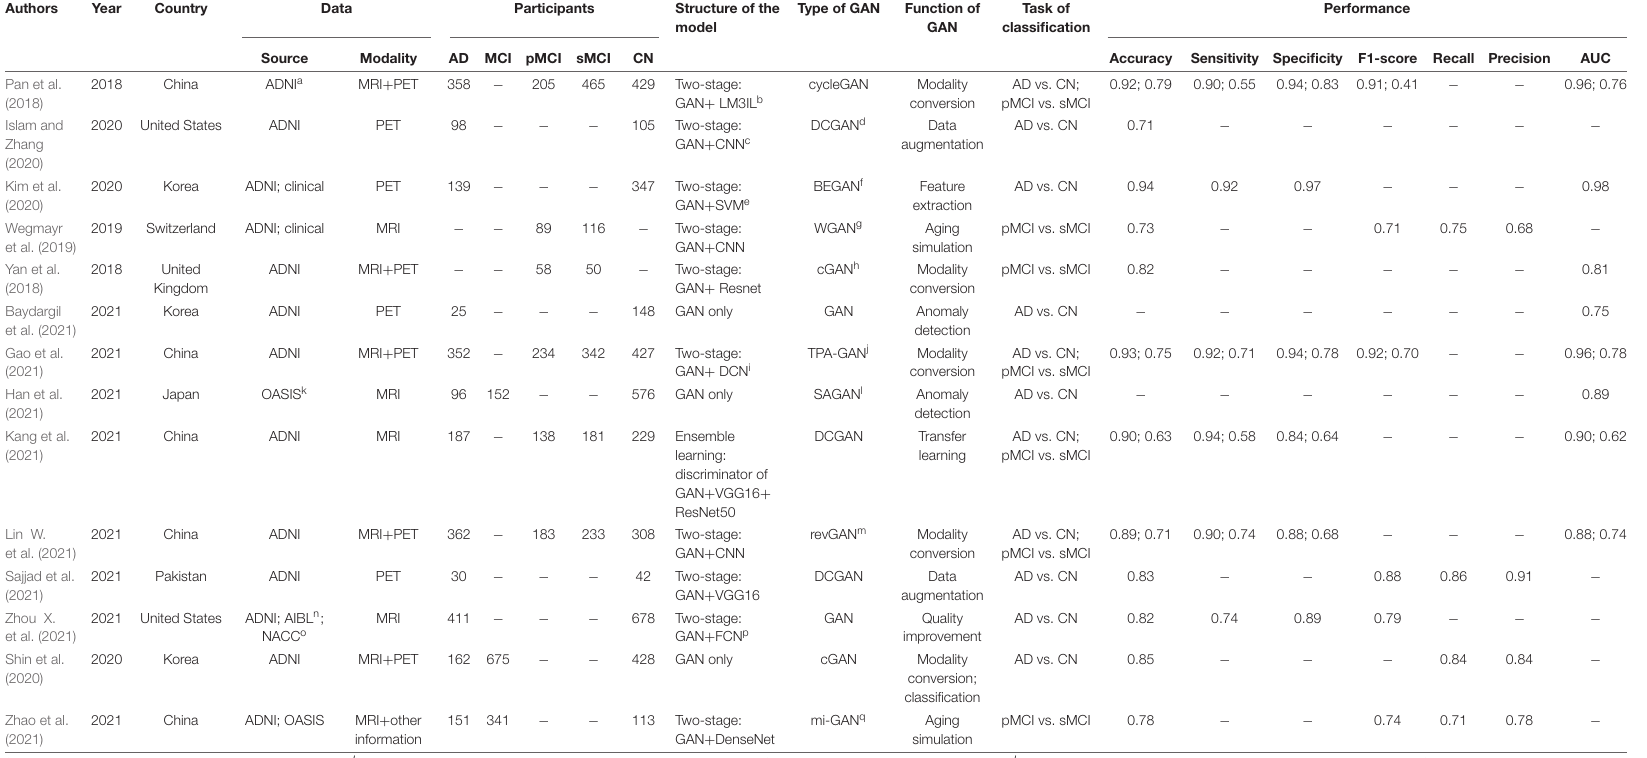
TABLE 1 | Characteristics of the included